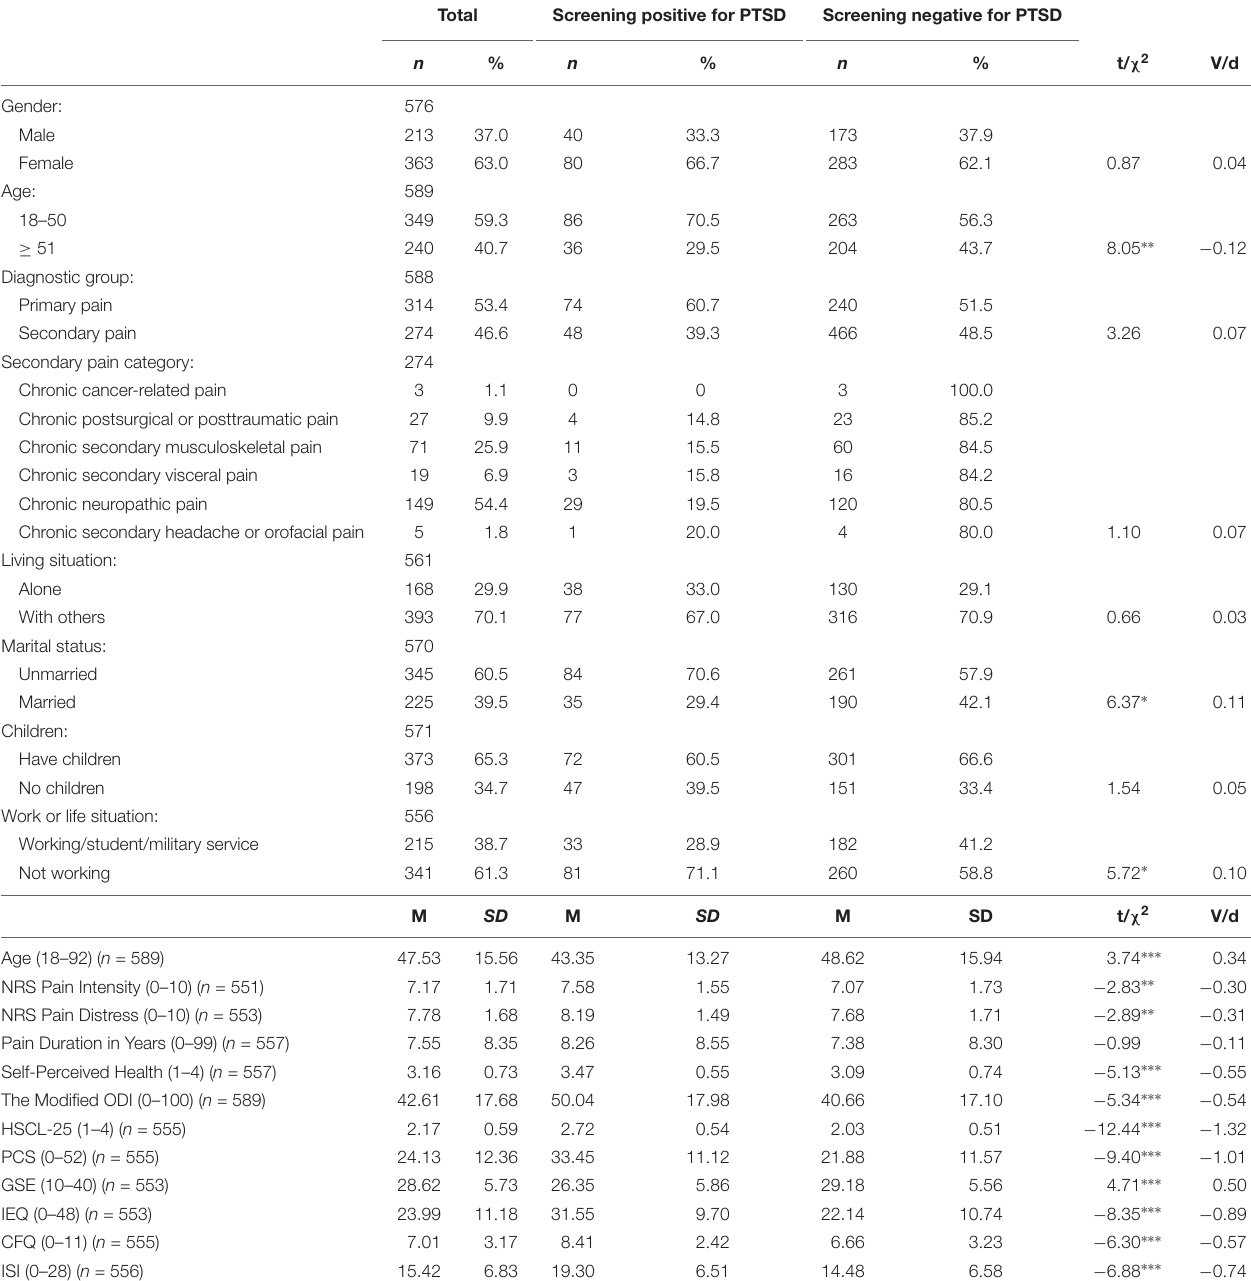
TABLE 1 | Chi-squared- and t -tests showing the differences between chronic pain patients screening positive and negative for PTSS at a level qualifying for a PTSD diagnosis in the study sample. Total Screening positive for PTSD Screening negative for